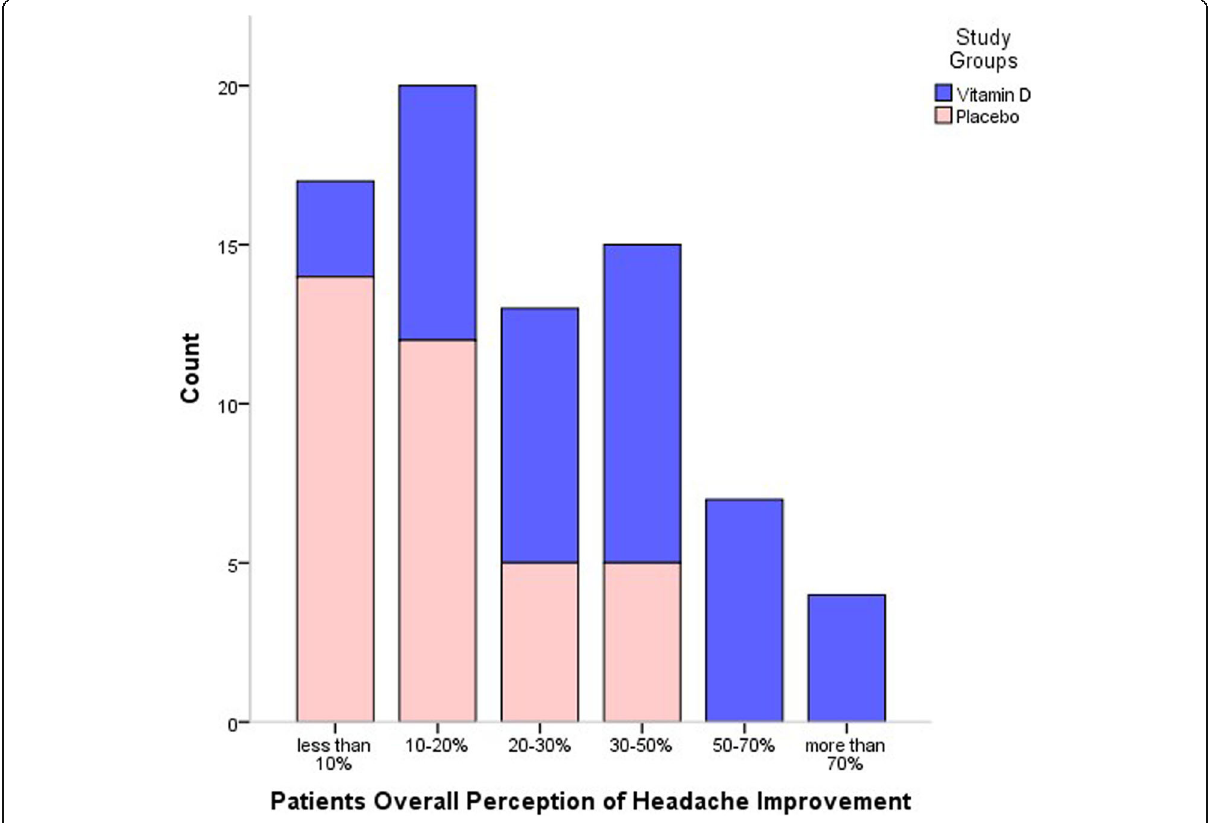
Fig. 3 Patients Overall Perception of Headache Improvement Following 12-week Trial. ( P value<